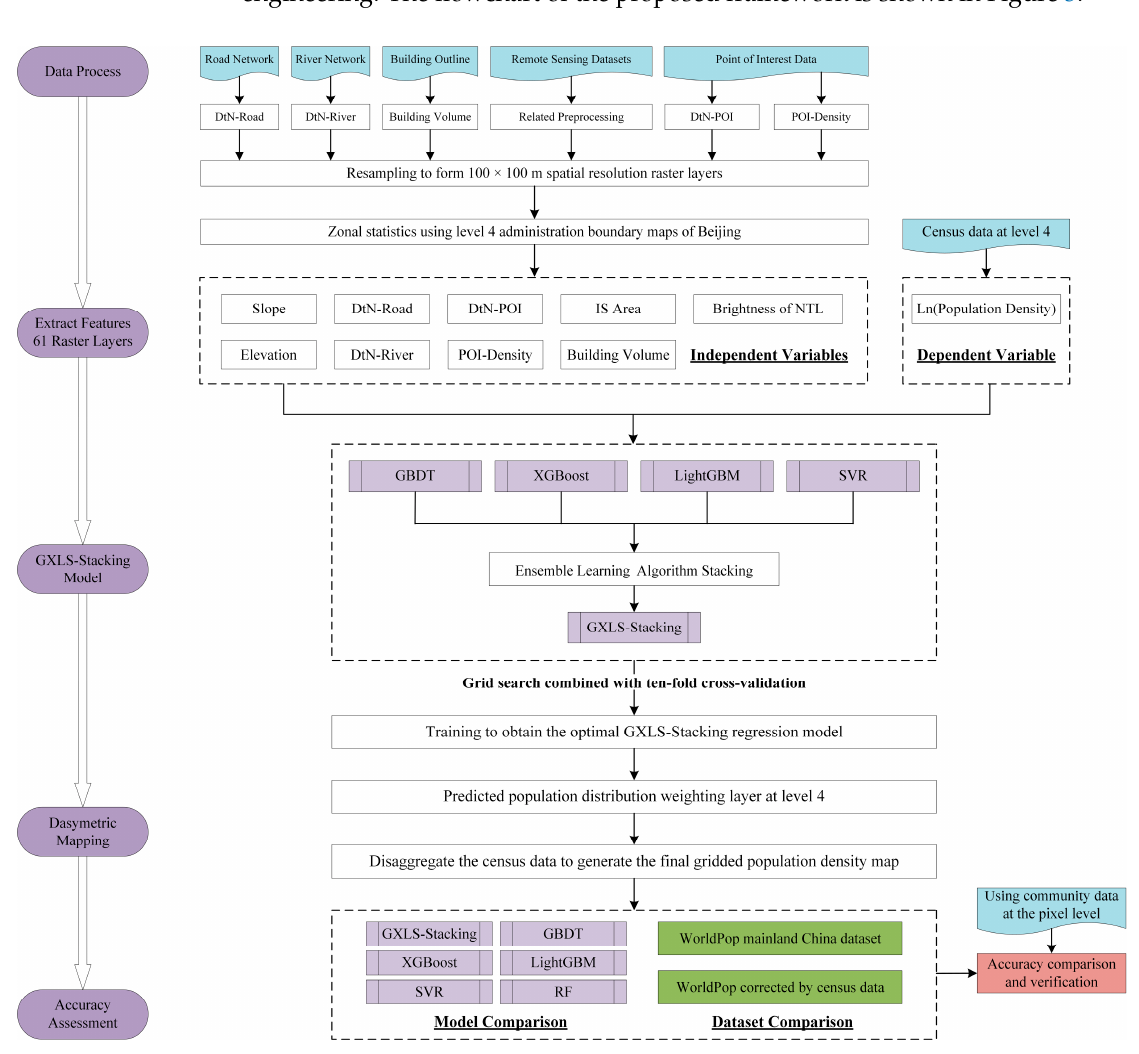
Figure 3. Flowchart of the proposed